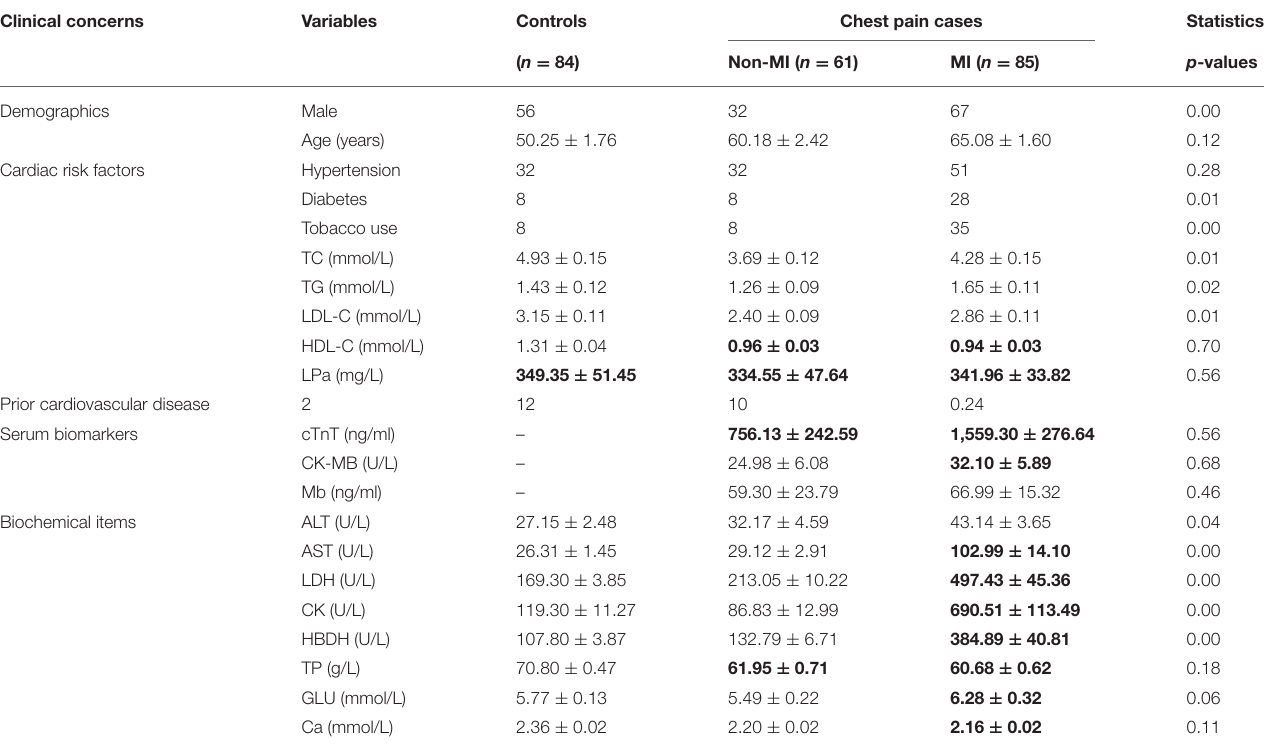
TABLE 2 | Sample characteristics: MI vs. non-MI chest pain